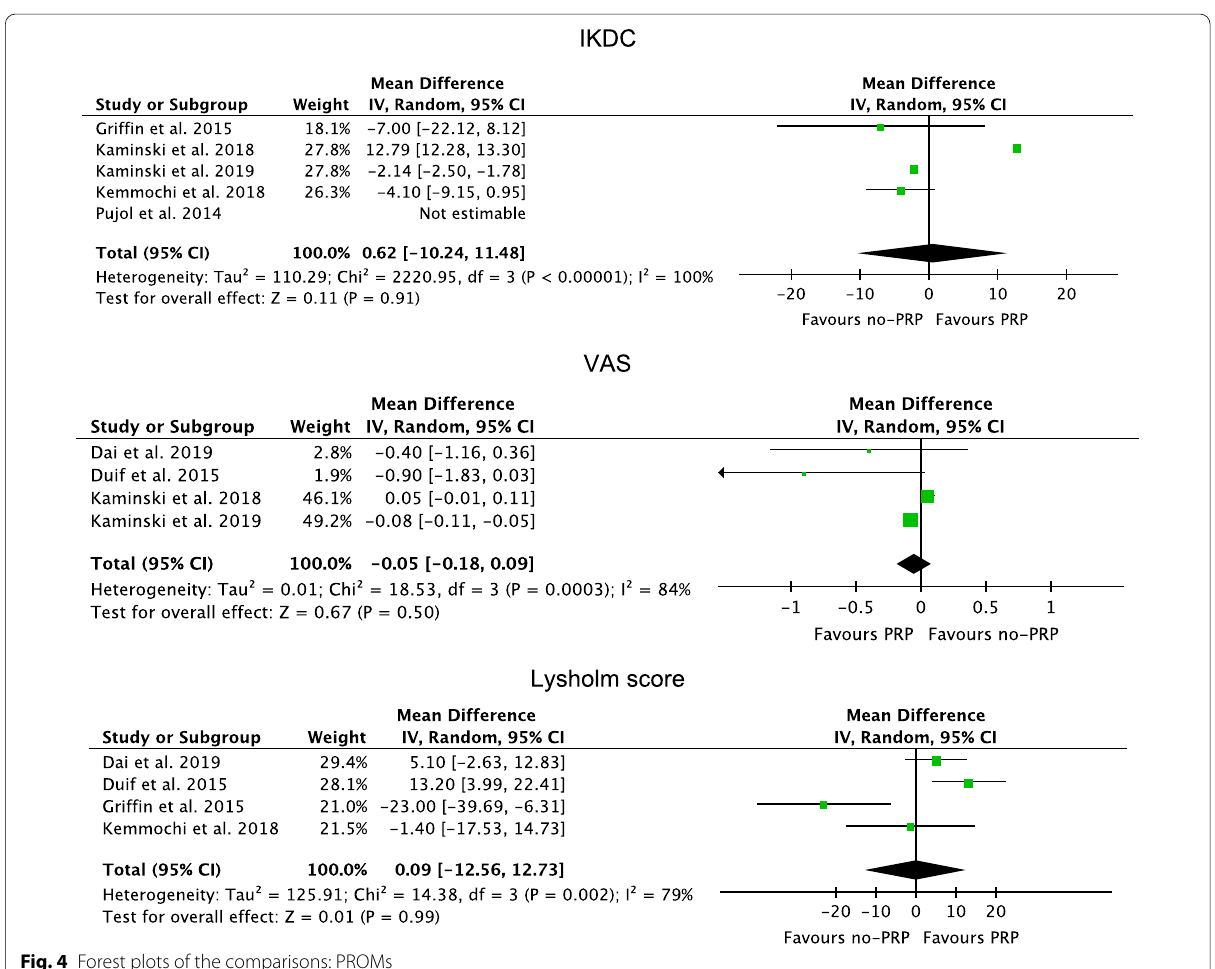
Fig. 4 Forest plots of the comparisons: